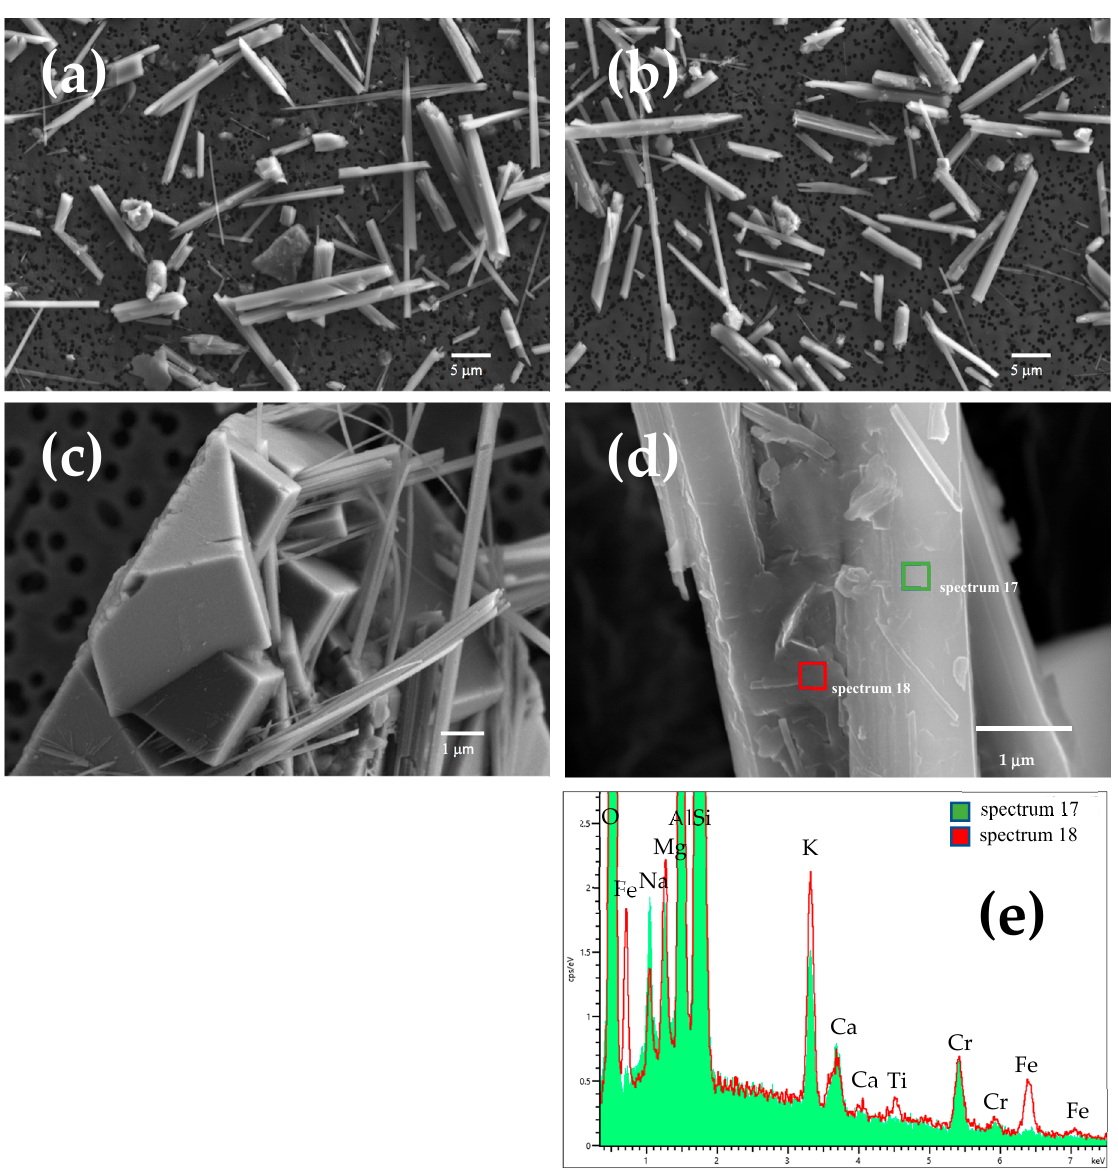
Figure 2. ( a ) FE-SEM image of pristine and ( b ) incubated for 1-month erionite fibres. ( c ) Rhombohedral chabazite crystals, ( d ) nontronite plates occurring on the fibre surface, and ( e ) EDS spectra showing that nontronite (red spectrum 18) is enriched in iron with respect to the erionite fibre (green spectrum 17). Inset: image of a single fibre made of smaller fibrils of ca. 100–200 nm of diameter.